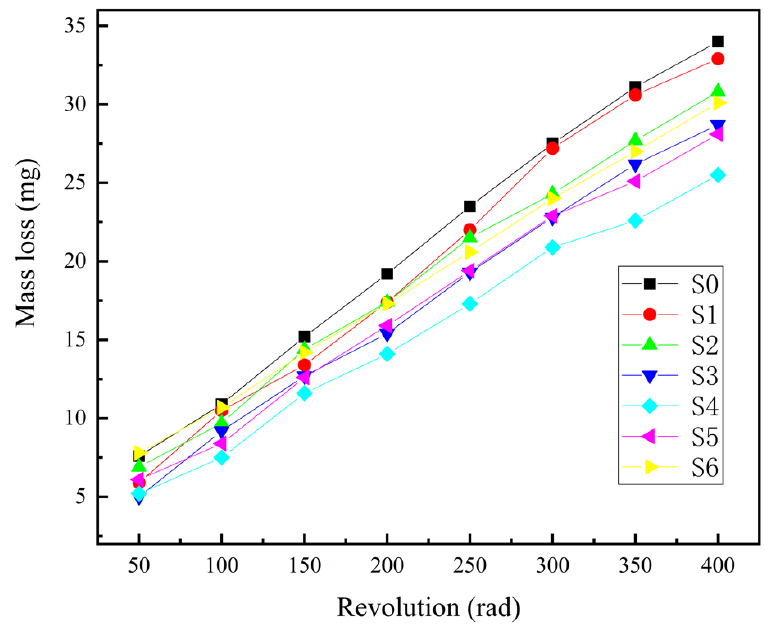
Figure 10. Wear curves of ceramic layer samples.